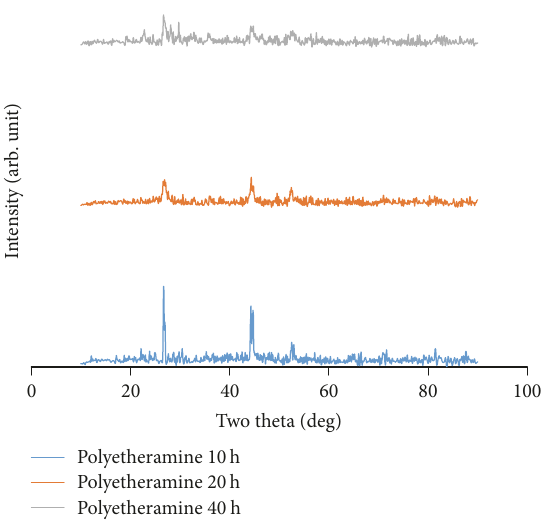
Figure 7: XRD pattern of synthesized CIS powder at 240 ∘ C for 10, 20, and 40 hours with